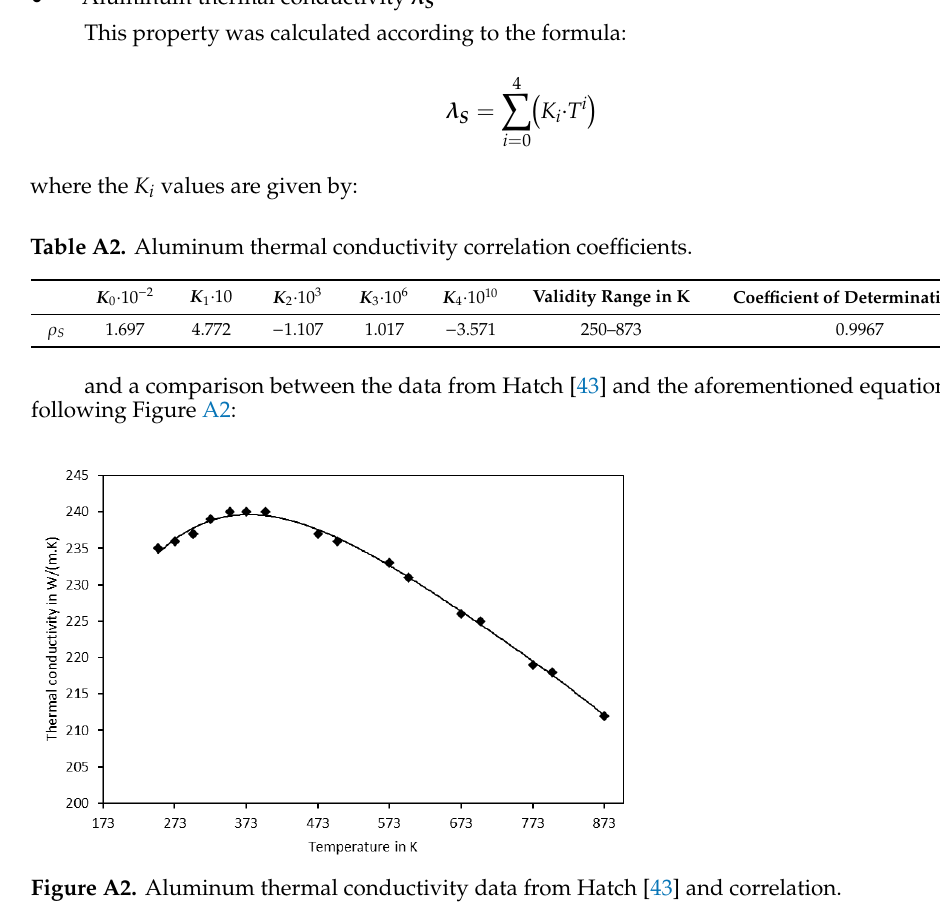
Figure A1. Aluminum density data from Rohsenow [40] and correlation (line).